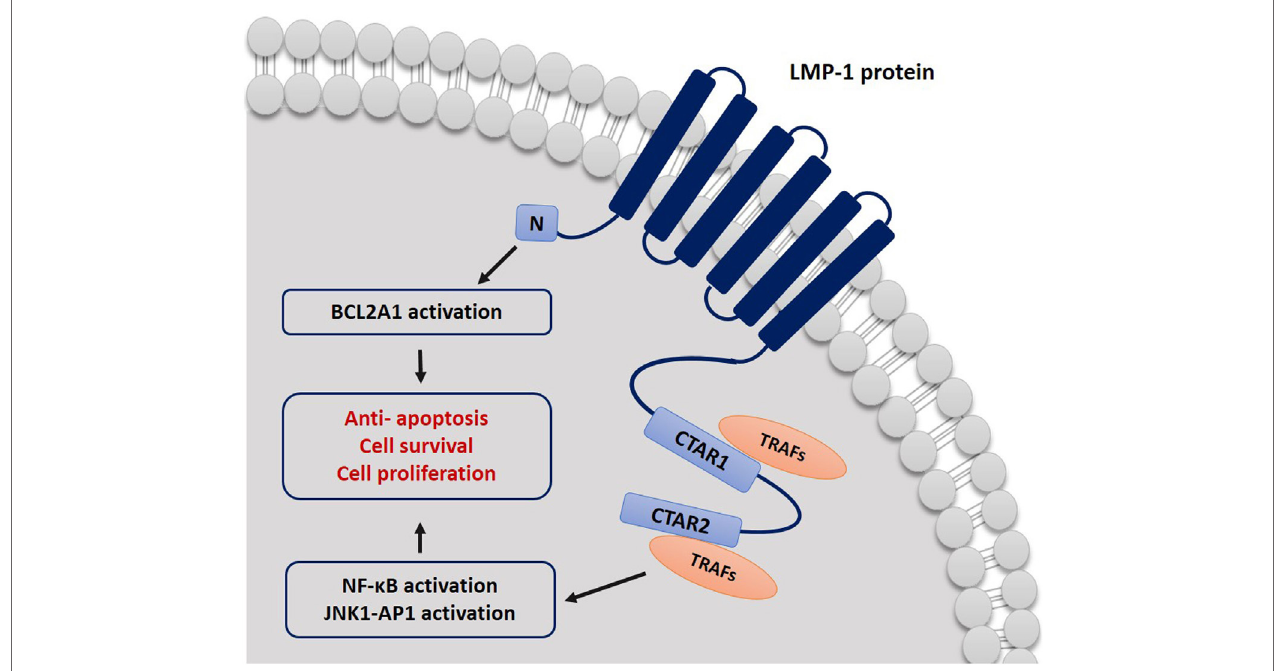
FiGURe 1 | Schematic representation describing the mechanism by which LMP-1 protein affects cell signal transduction. CTAR1 and CTAR2 bind to TRAF proteins and activate NF- κ B and JNK–AP-1 pathways. LMP-1 can block cell apoptosis signals by activating BCL2A1. FiGURe 2 | Epstein–Barr virus (EBV) life cycle in healthy carriers. The infection begins when EBV infect epithelial cells and naïve B cells of the oral cavity. EBV genome will be transported to the nucleus of B cell where it will replicate and results in the proliferation of B cells. Latency occurs when EBV downregulate most of its protein-encoding genes. Later, as cells recirculate between peripheral and oral compartments, resting B cells will be reactivated and cause viral shedding.